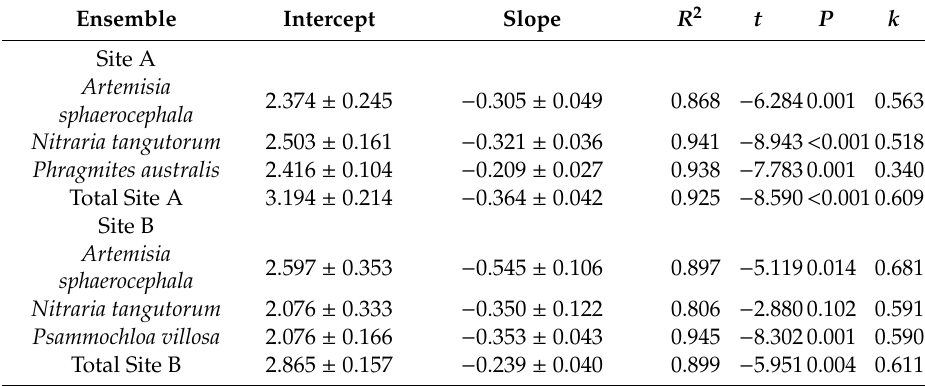
Figure 4. Proportion of the tenebrionid beetle species collected in two sites (A and B) in the Ulan Buh Desert (Gobi Desert, Inner Mongolia, China). For insect species names, see Table 1. The goodness-of-fit statistics of the OLS regression lines (Table 2) indicated that the geometric series fitted adequately all species ensembles (Figure 5) and the two whole communities (Figure 6). The lack of significance of the regression line for N. tangutorum in Site B is due to the small number of involved species (only four data points), whereas the goodness-of-fit is high (more than 80% of variance explained). Table 2. Regression parameters (intercept and slope), goodness of fit ( R 2 ), t-value ( t ) and probability ( P ) of geometric series models for the tenebrionid ensembles associated with four plant species in two sites in the Ulan Buh Desert (Gobi Desert, Inner Mongolia). For each model, the niche pre-emption parameter k is also reported. Errors refer to standard